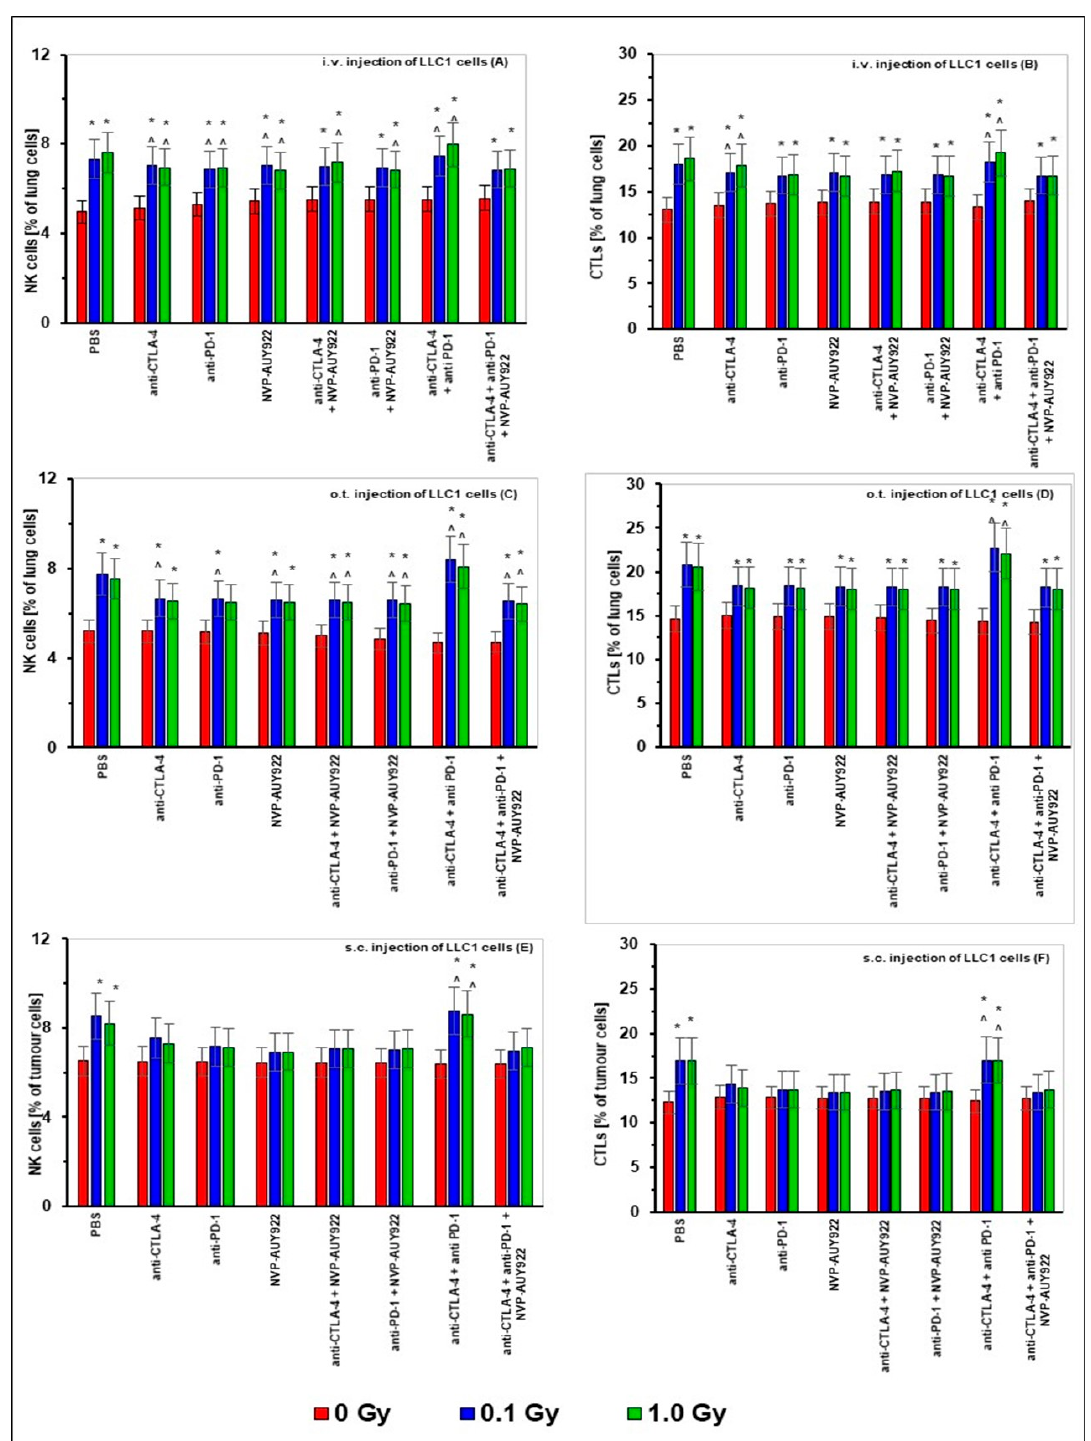
Figure 5. The percentages of natural killer (NK) cells (panels A , C , E ) and cytotoxic T lymphocytes (CTLs) (panels B , D , F ) in the lungs after i.v. (panels A , B ) or o.t. (panels C , D ) injection with LLC1 cells or in tumors after s.c. (panels E , F ) injection of LLC1 cells to C57BL/6 mice treated with blockers of the immune checkpoints and/or HSP90 combined with WBI at total doses of 0.1 and 1.0 Gy. The bars indicate mean percentages of NK cells and CTLs calculated for six (i.v. and o.t. injection of tumor cells) or three (s.c. injection of tumor cells) mice per group are presented. * indicates statistically significant ( p < 0.05) difference from the results obtained in the sham-exposed mice injected with PBS; ^ indicates statistically significant ( p < 0.05) difference from the results obtained in the sham-exposed mice injected with the same inhibitory molecule or a combination of these molecules.